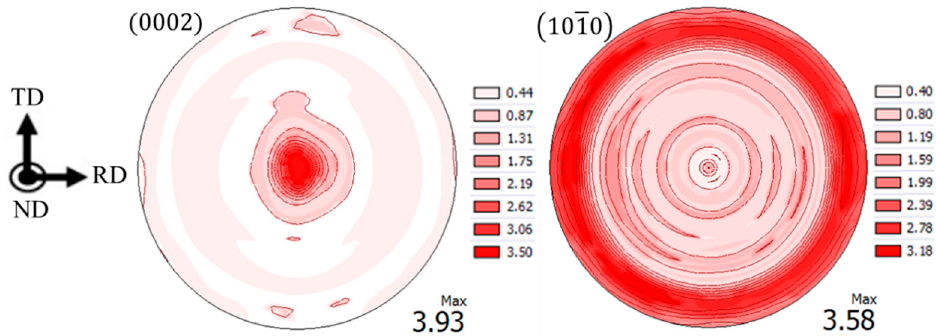
Figure 4. Texture of AZ31B-H24 rolled sheet used in this study.